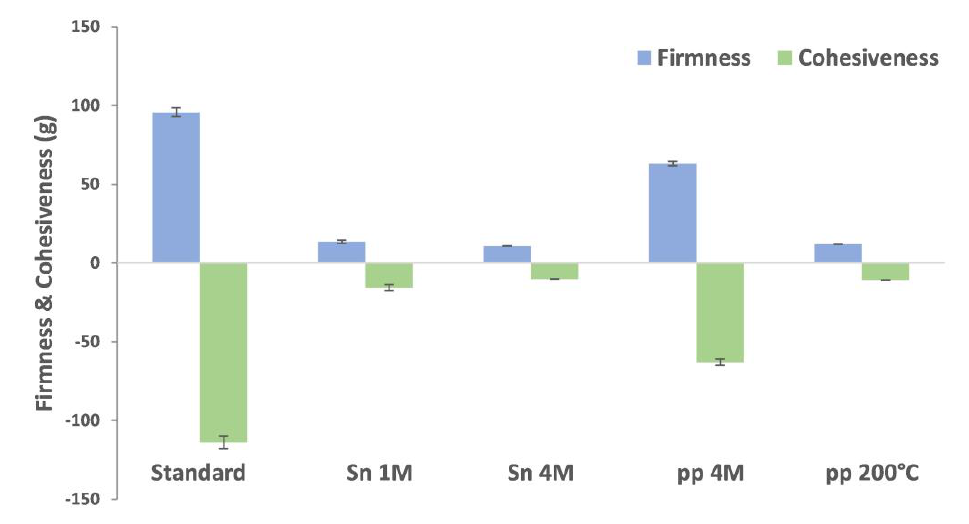
Figure 5. Firmness and cohesiveness of standard mayonnaise (3% of egg yolk + modified starch) and mayonnaises with addition of 1% BSY extracts (Sn 1M, Sn 4M, pp 4M, and pp 200 °C).